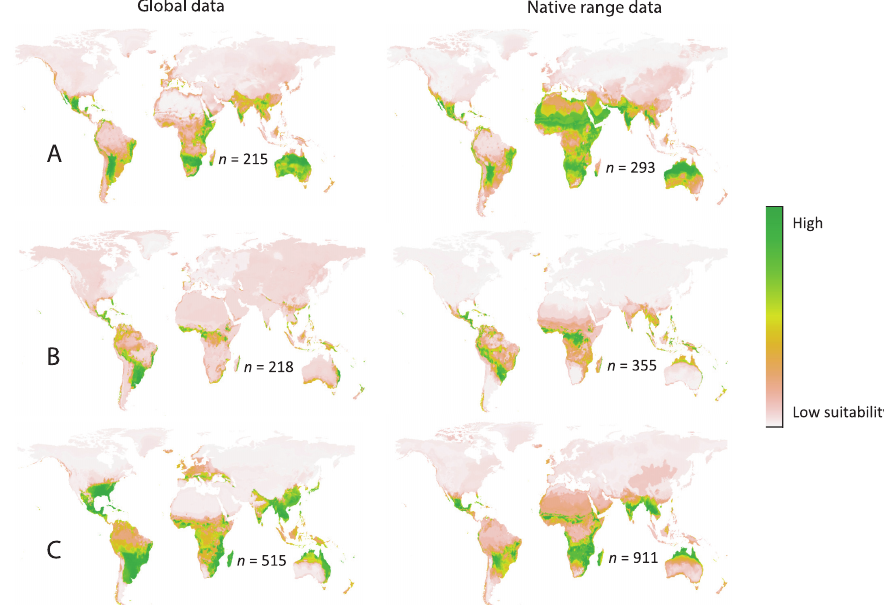
Figure 4. Species distribution modelling of Cardiospermum species. Global climatically suitable ranges for A C. corindum B C. grandiflorum , and C C. halicacabum as predicted by boosted regression trees in BIOMOD using global (left) and native range data (right). Number of occurrence points used for model- ling ( n ) is indicated on each